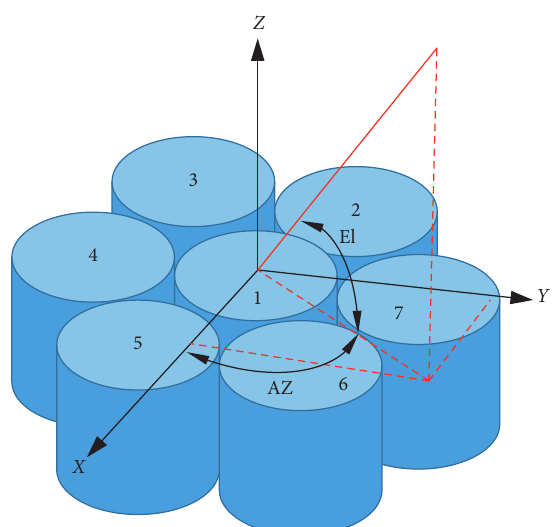
Figure 1: A 3D illustration of the 7-element CBSA NSA. The phase-reference center is at the first element center.